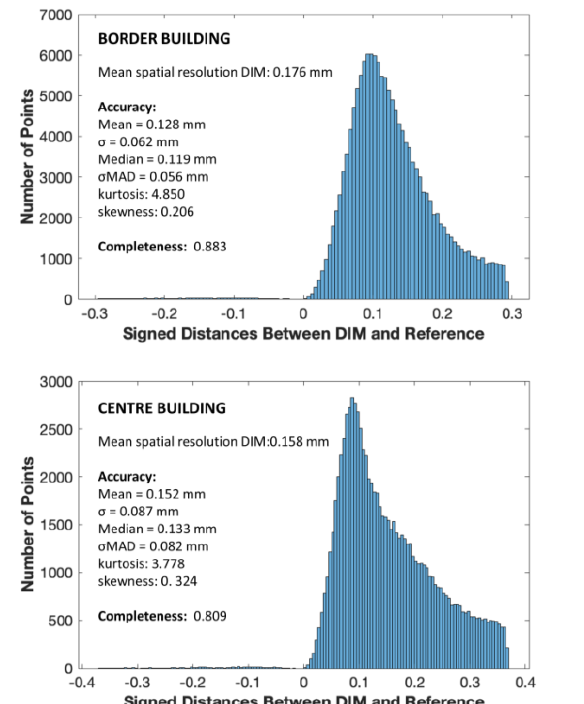
Figure 4. Result of the accuracy and completeness assessments performed on the reference DIM point cloud.